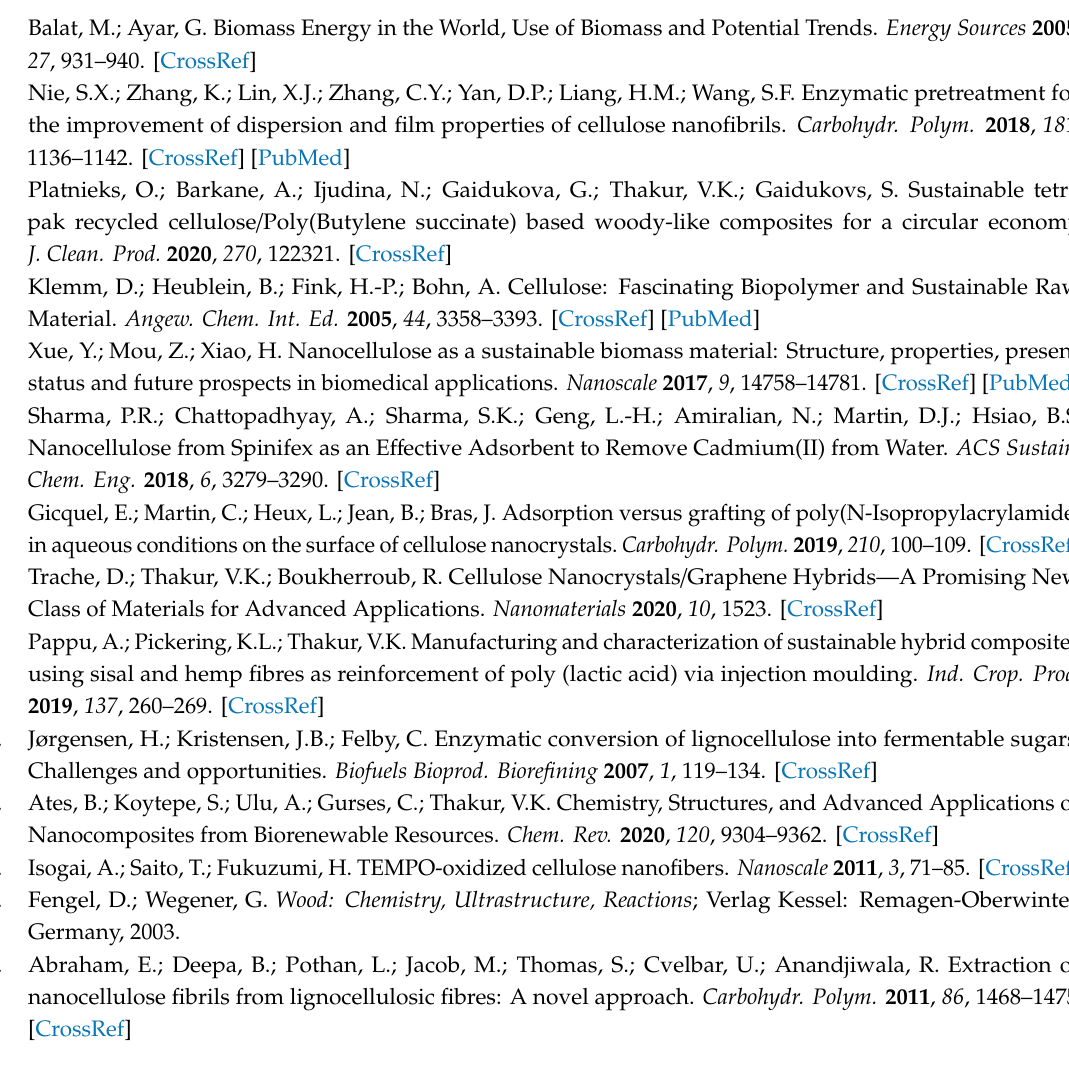
Figure S1. AFM 3D image of CNF samples; Figure S2. (a) TEM image of the CNFs; (b) diameter distribution of the CNFs (AD: average diameter); Figure S3. A TEM diagram of the bagasse treated in the 85 wt. % H 3 PO 4 aqueous solution for 24 h; Figure S4. XRD patterns of the bagasse treated in the 85 wt. % H 3 PO 4 aqueous solution for 24